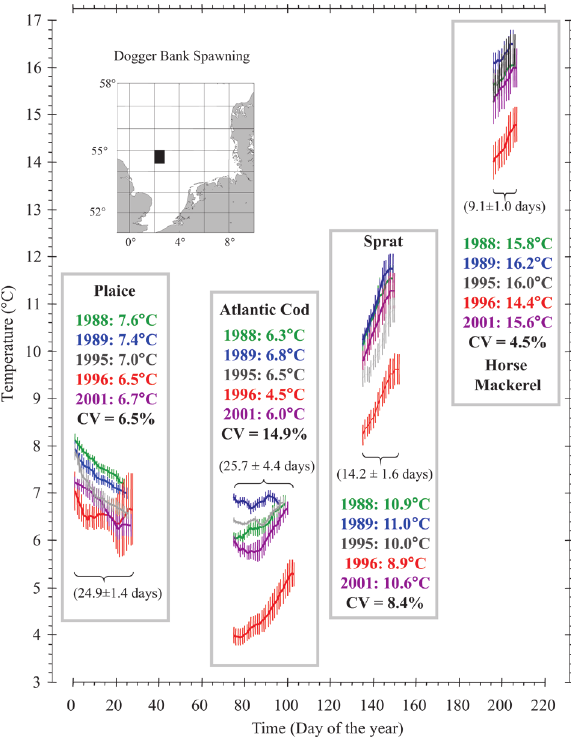
F IG . 3. – Mean temperatures experienced during the drift of 2188 particles (eggs and yolksac larvae) of plaice, Atlantic cod, sprat and horse mackerel released on day 0, day 75, day 135 and day 196 respectively, on Dogger Bank (insert) in each of the five years. Mean temperatures (averaged over the entire drift phase) and mean (± range) in drift duration for the five years are also provided.